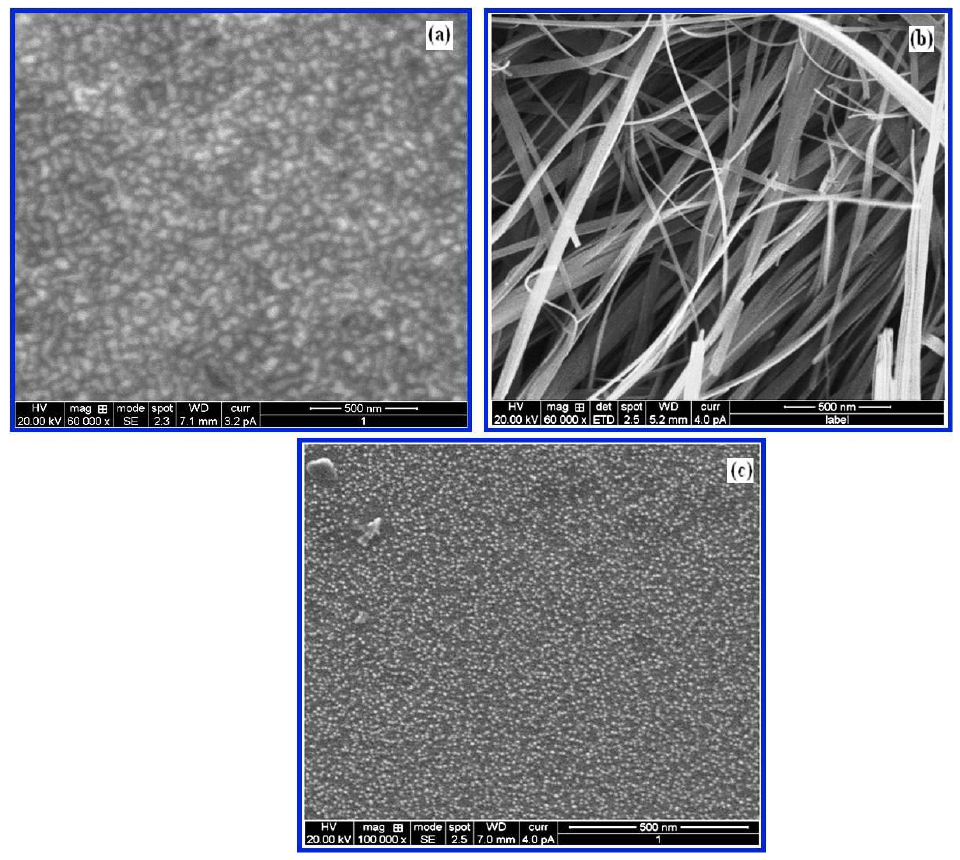
Figure 3. FE-SEM images of γ-Fe 2 O 3 nanostructures synthesized using different % (1%, 2% and 3%) of AV extract ( a ) nanoparticle aggregates ( b ) nanobelts and ( c ) nanodots, respectively.